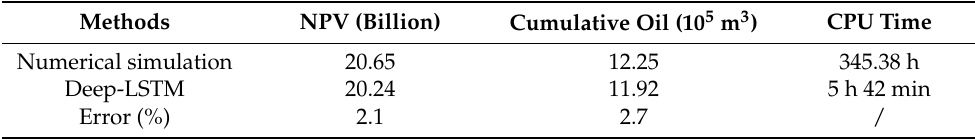
Table 10. Comparison of optimization results of different